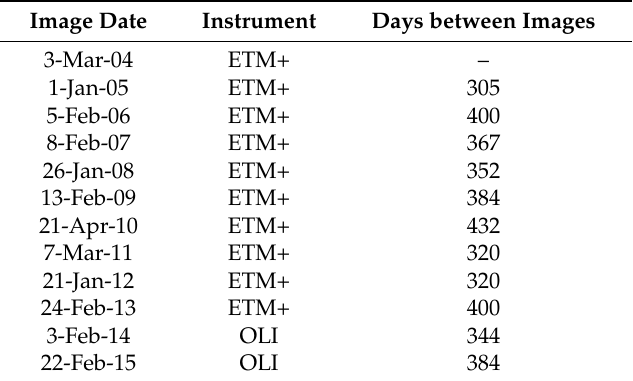
Table 1. List of Landsat images used this study. Image Date